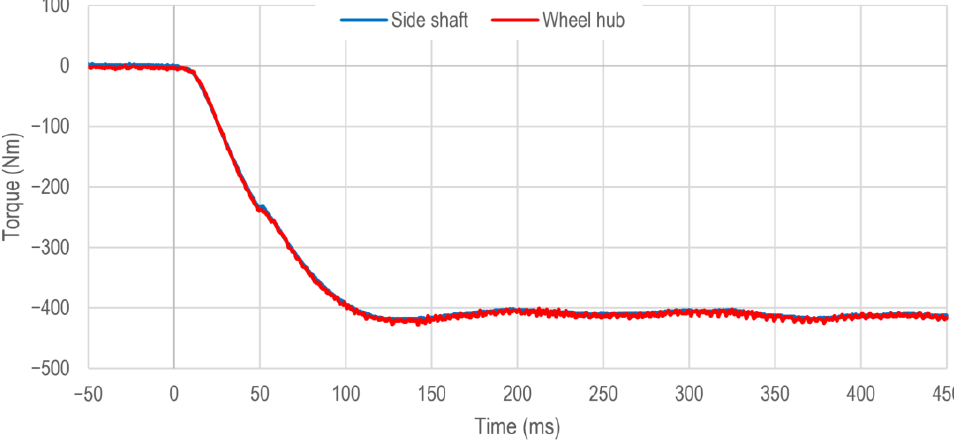
Figure 11. Regenerative braking operation from 25 km/h with activated prefilter and anti-jerk control. The time courses of both torques are again almost congruent during the observed period. However, due to the anti-jerk control, the torque build-up is slightly slower. Thus, after t 63 = 57 ms both torques amount to 63% of the desired drivetrain torque M DrTrnD and after t 90 = 85 ms the value of 90% of the desired drivetrain torque is